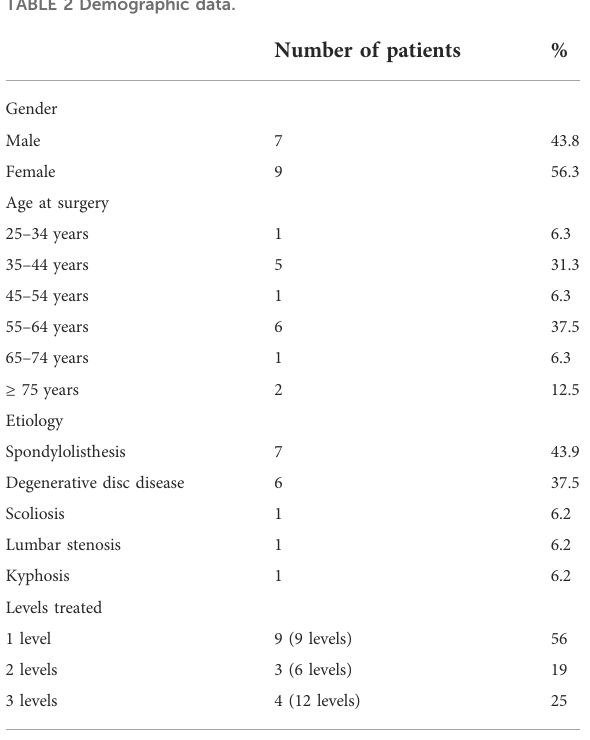
TABLE 2 Demographic data.